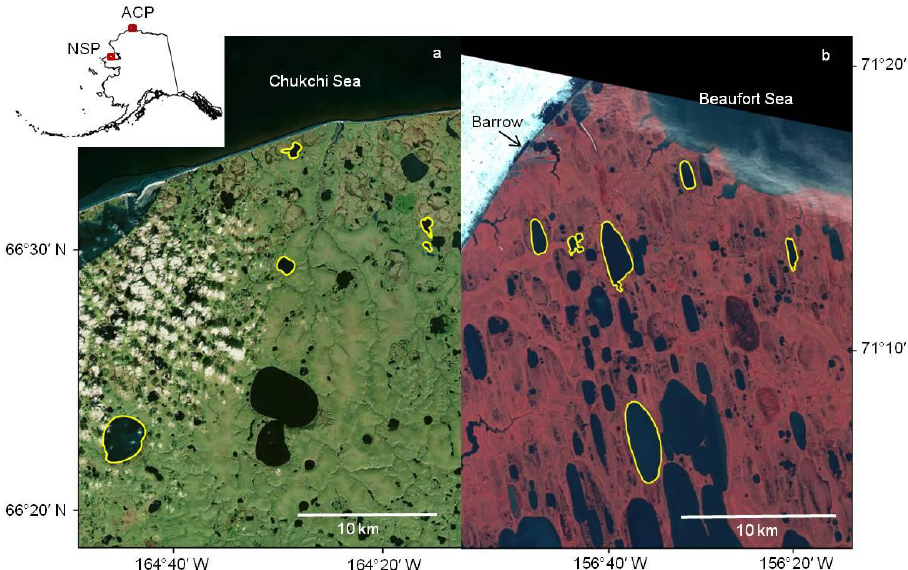
Fig. 1. Study lakes are highlighted in yellow on (a) northern Seward Peninsula (NSP) and (b) Arctic Coastal Plain (ACP) south of Barrow. In panel (a) the large lake in the lower left is Whitefish Maar and the double-lobed lake in the center bottom is Devil Mountain Maar, both of volcanic origin; all other study lakes in both regions are of thermokarst origin. Panel (a) is a Spot 5 mosaic from the Geographic Information Network of Alaska and panel (b) is a scene from 10 July 2008 AVNIR-2 (Advanced Visible and Near Infrared Radiometer type 2).